Question: What form of chart is displayed?
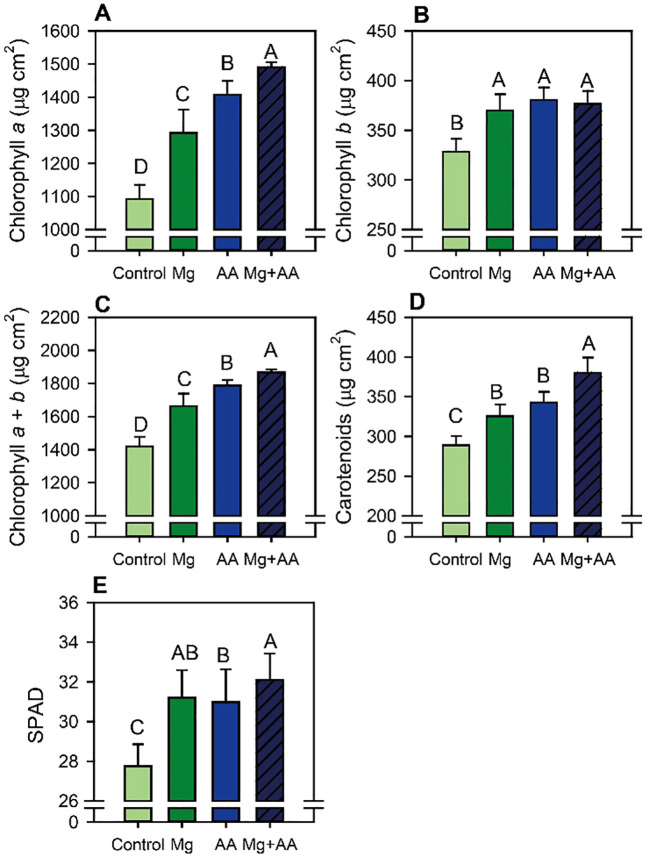
Answer: bar